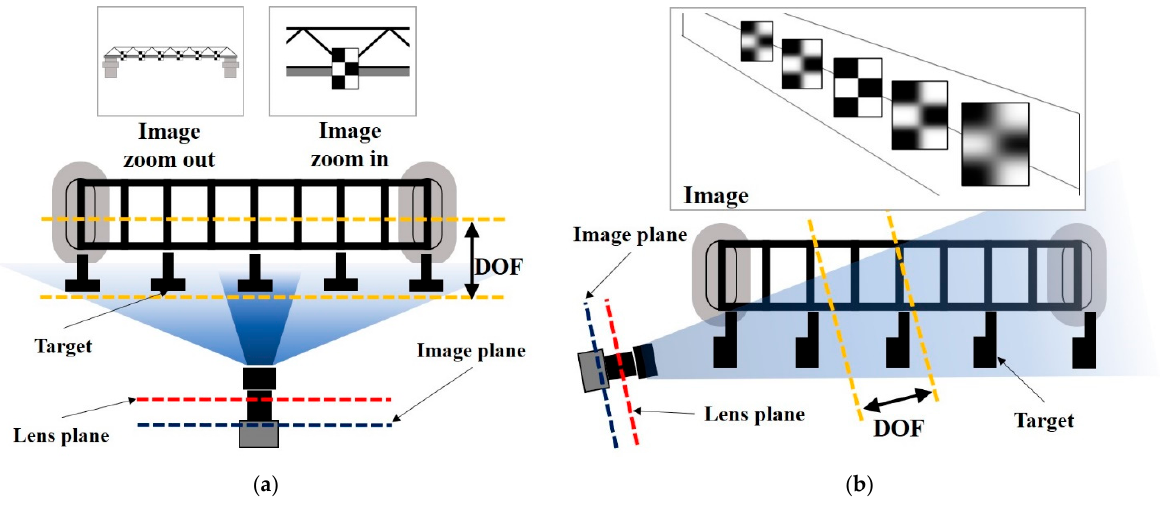
Figure 1. Limitations in vision-based bridge displacement measurement using conventional camera. ( a ) Side-view measurement. ( b ) Front-view measurement.